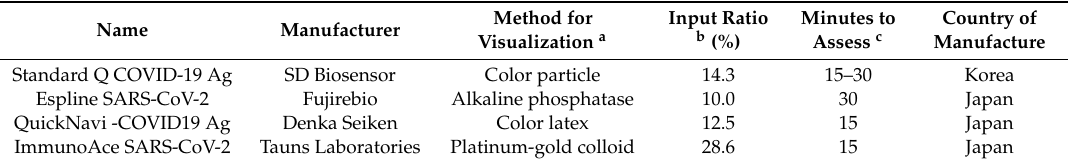
Table 1. Rapid antigen tests examined in this